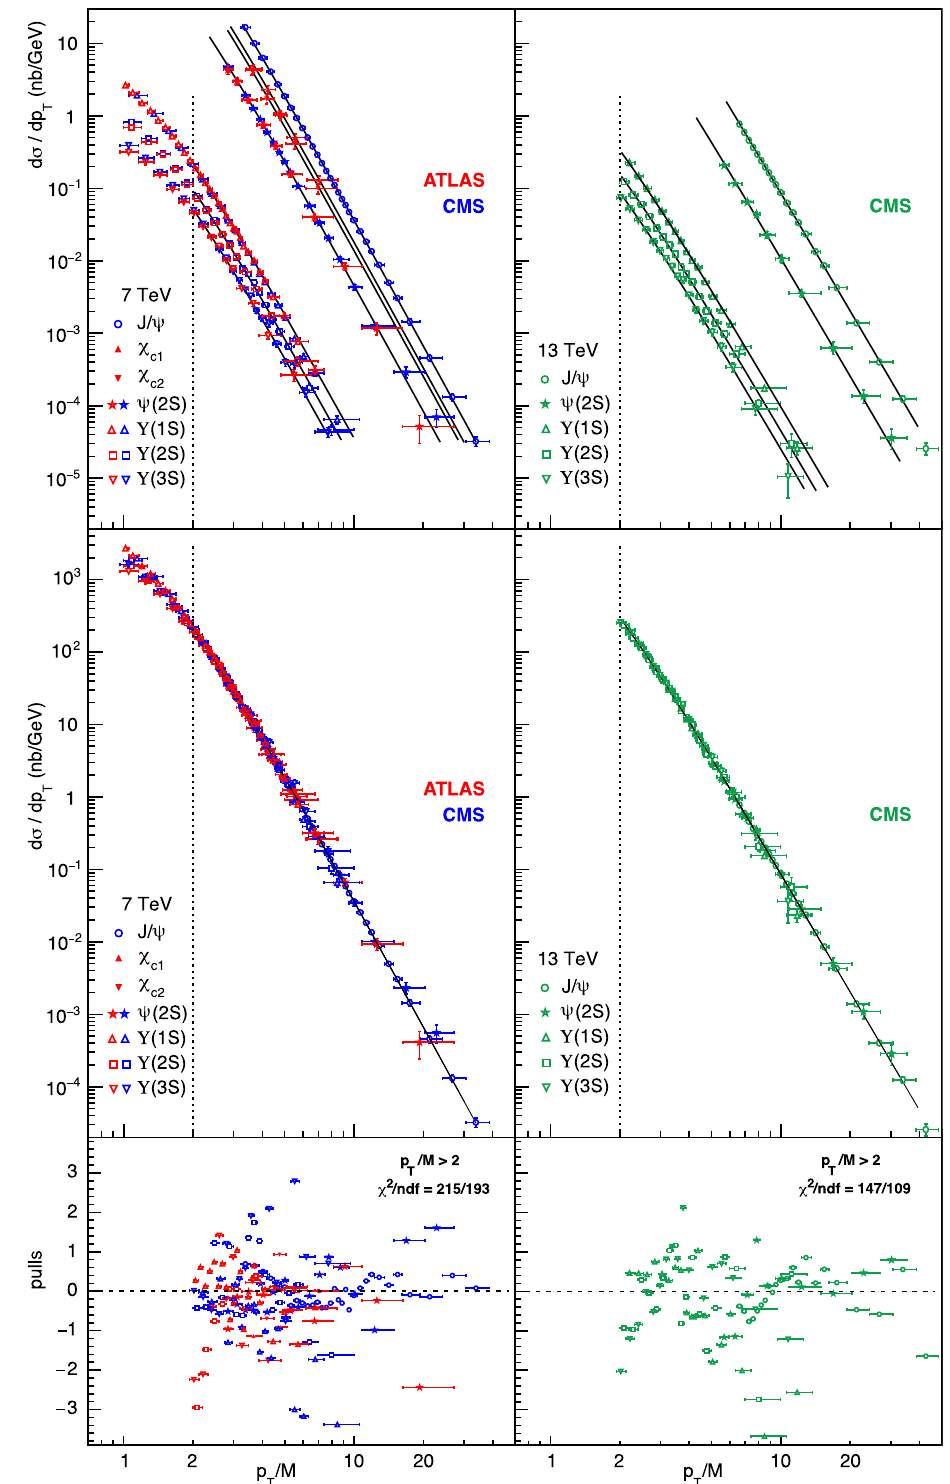
Fig. 2 Mid-rapidity prompt quarkoniumcrosssectionsinppcollisions √ s = 7TeV (left) and 13TeV (right), as measured by ATLAS (red at markers) [16–18] and CMS (blue and green markers) [19–21] (top pan- els), and after scaling up all the normalizations to match those of the J /ψ cases (middle panels). For each collision energy, the curves rep-